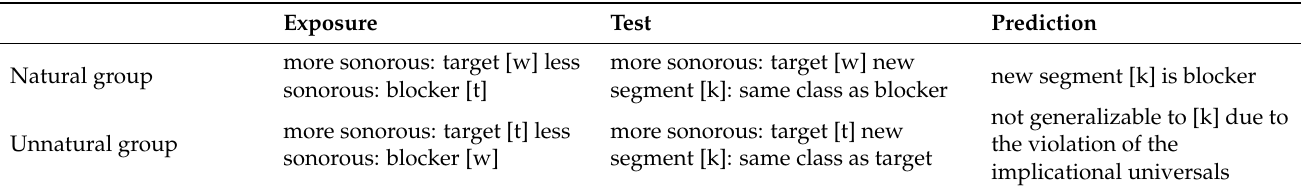
Table 3. Predictions concerning the generalizability of natural and unnatural